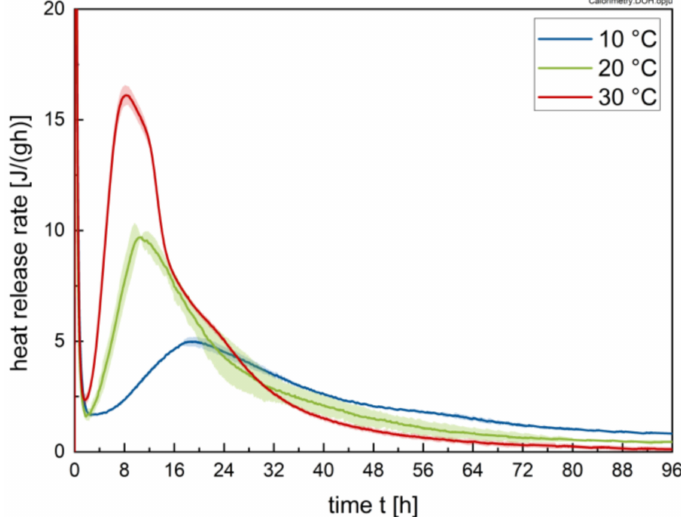
Figure 3. Heat release rate of the cement pastes with w / c = 0.41 without superplasticizer addition at temperatures of 10, 20 and 30 ◦ C, respectively, for a time interval of 96